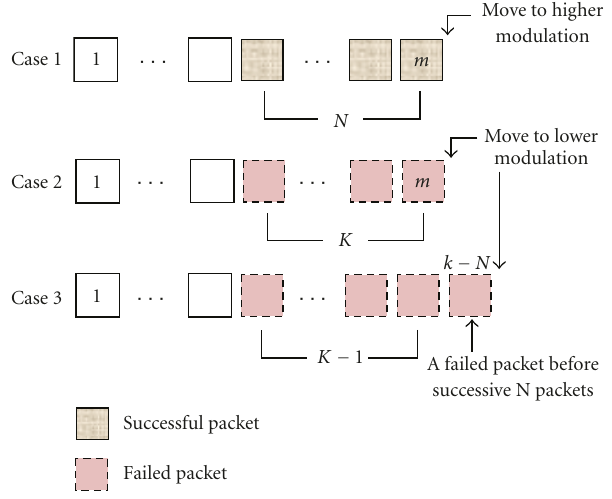
Figure 4: Three complement cases for A u ( k − N − 1, q